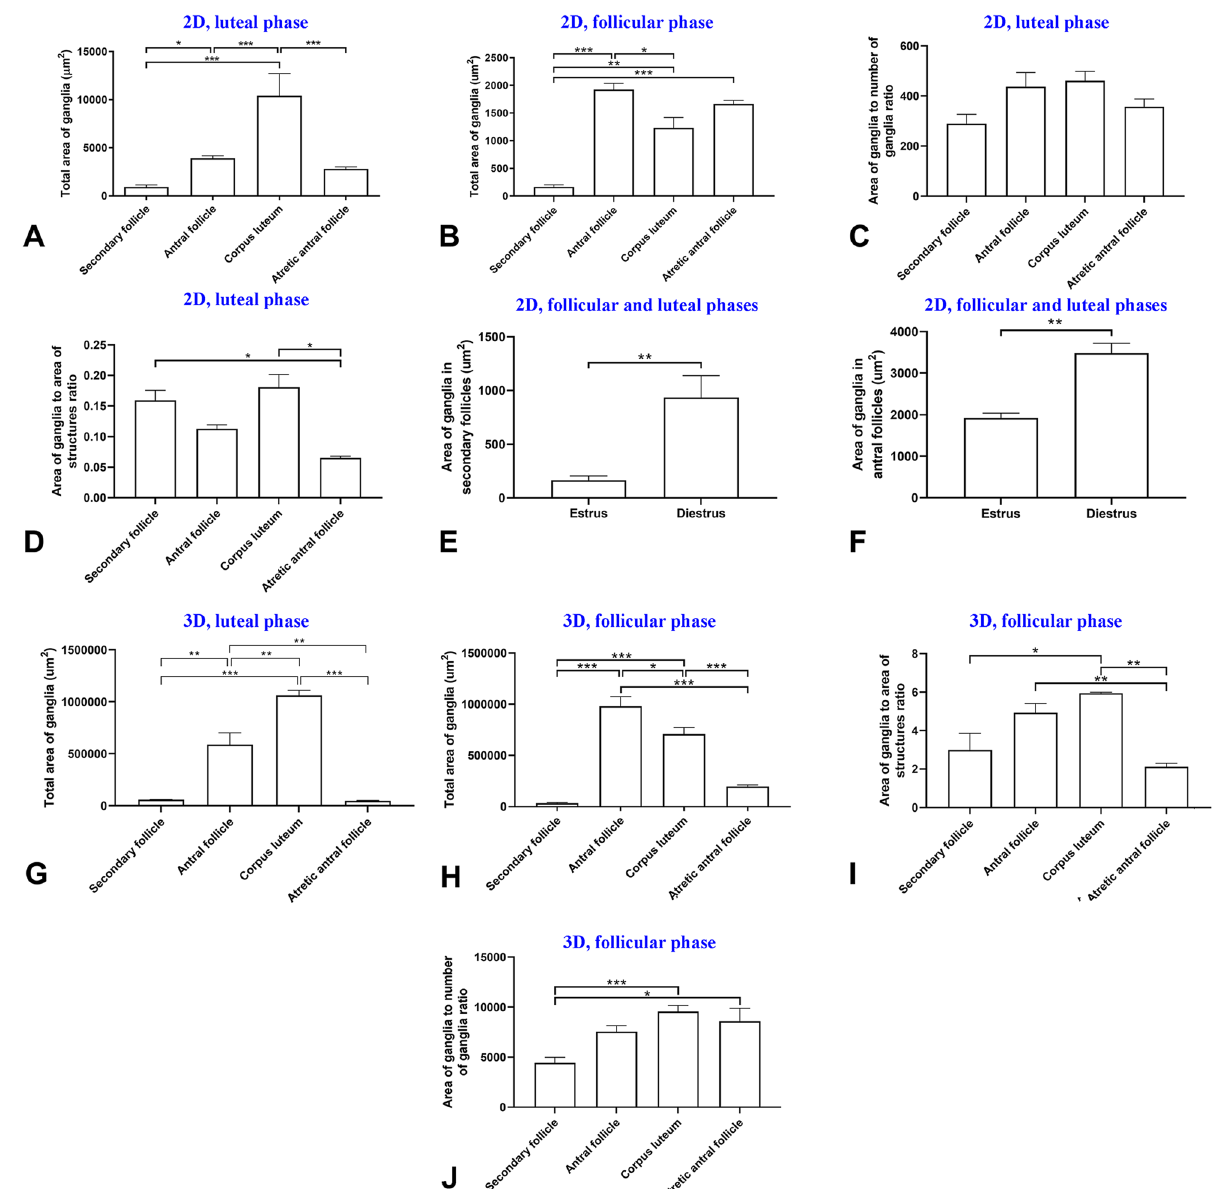
Figure 4. Comparisons of means and standard errors of variables in the three-dimensional (3D) and two- dimensional (2D) studies to show the relationship of follicular growth and increase in ganglia area in the mouse ovary. Area of ganglia in luteal phase ( A ) and follicular phase ( B ) phases in follicles and corpora lutea in the 2D study. ( C ) Area of ganglia to number of ganglia ratio in luteal phase in the 2D study. ( D ) Area of ganglia to area of structures ratio in luteal phase in the 2D study. ( E ) Area of ganglia in the secondary follicles in follicular and luteal phases in the 2D study. ( F ) Area of ganglia in the antral follicles in follicular and luteal phases in the 2D study. ( G ) Area of ganglia in follicles and corpora lutea in the 3D study. ( H ) Area of ganglia to area of structures ratio in the 3D study. ( I ) Area of ganglia to number of ganglia ratio in the 3D study (* p < 0.05, ** p < 0.01, *** p <